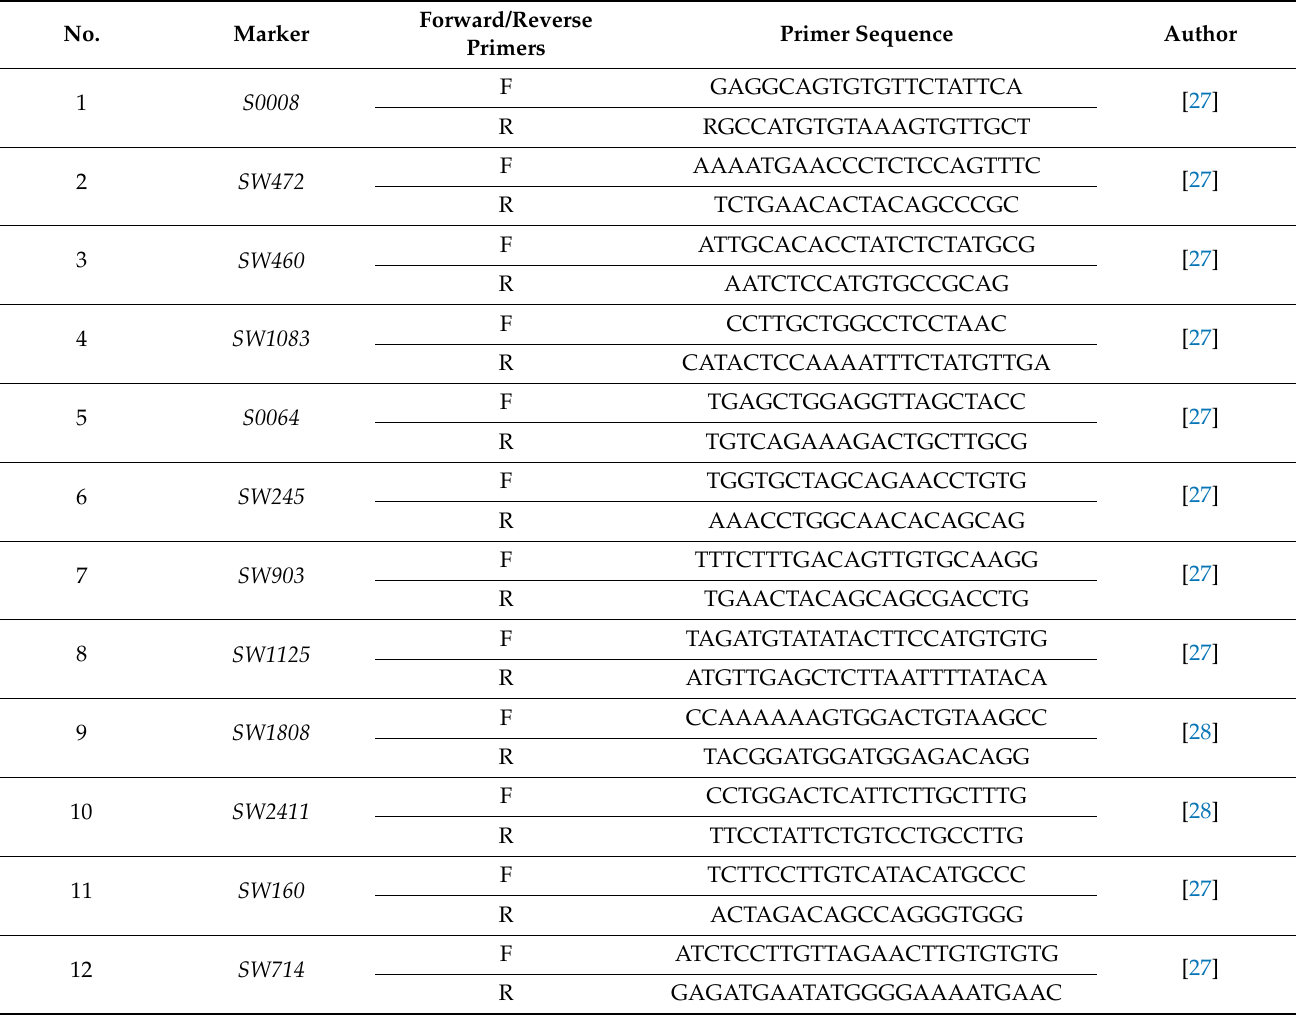
Table 1. Characteristics of microsatellite markers: name, primer sequences, and